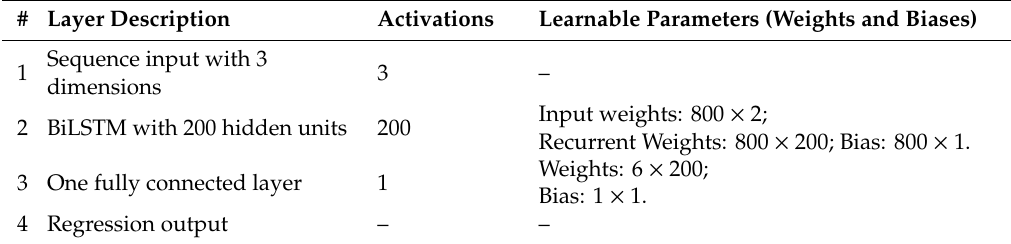
Table 4. Layers of the LSTM after feature extraction.